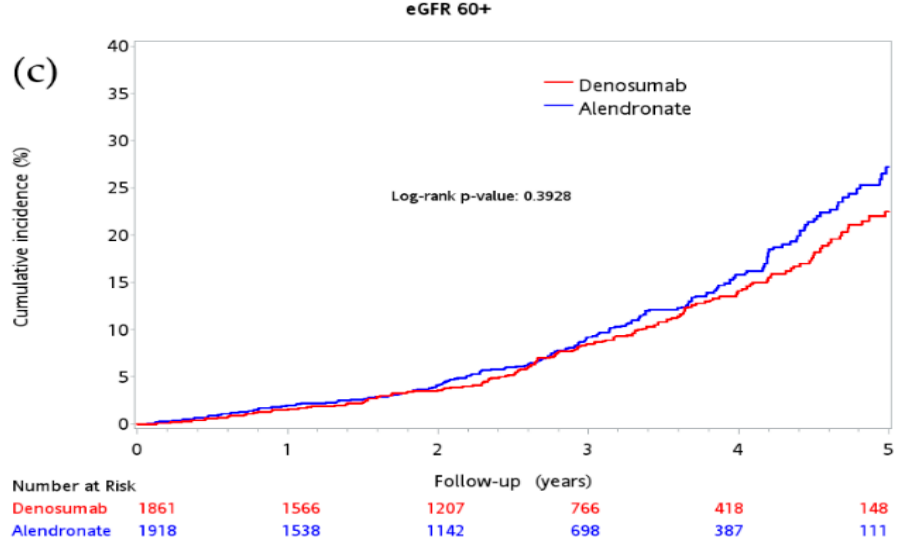
Figure 3. Cumulative incidence of eGFR decline ≥ 30% between the denosumab and alendronate groups: All patients ( a ); patients with eGFR < 60 mL / min / 1.73 m 2 at baseline ( b ); patients with eGFR ≥ 60 mL / min / 1.73 m 2 at baseline ( c ); eGFR: estimated glomerular filtration rate. Table 4. Renal outcomes in the denosumab and alendronate groups during the follow-up period. Denosumab Alendronate p- Value ( n = 2523) ( n = 2523) Decline in eGFR (per year), -0.25 ± 30.91 1.46 ± 48.24